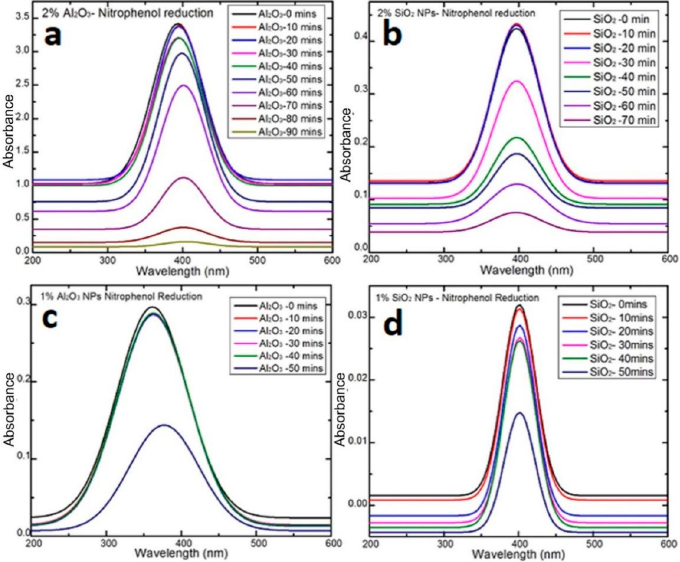
Figure 4. UV-Visible spectra recorded during the degradation of 4 NP in the presence silver added ( a ) 2% Al 2 O 3 NF, ( b ) 2% SiO 2 NF, ( c ) 1% Al 2 O 3 NF and ( d ) 1% SiO 2 NF.